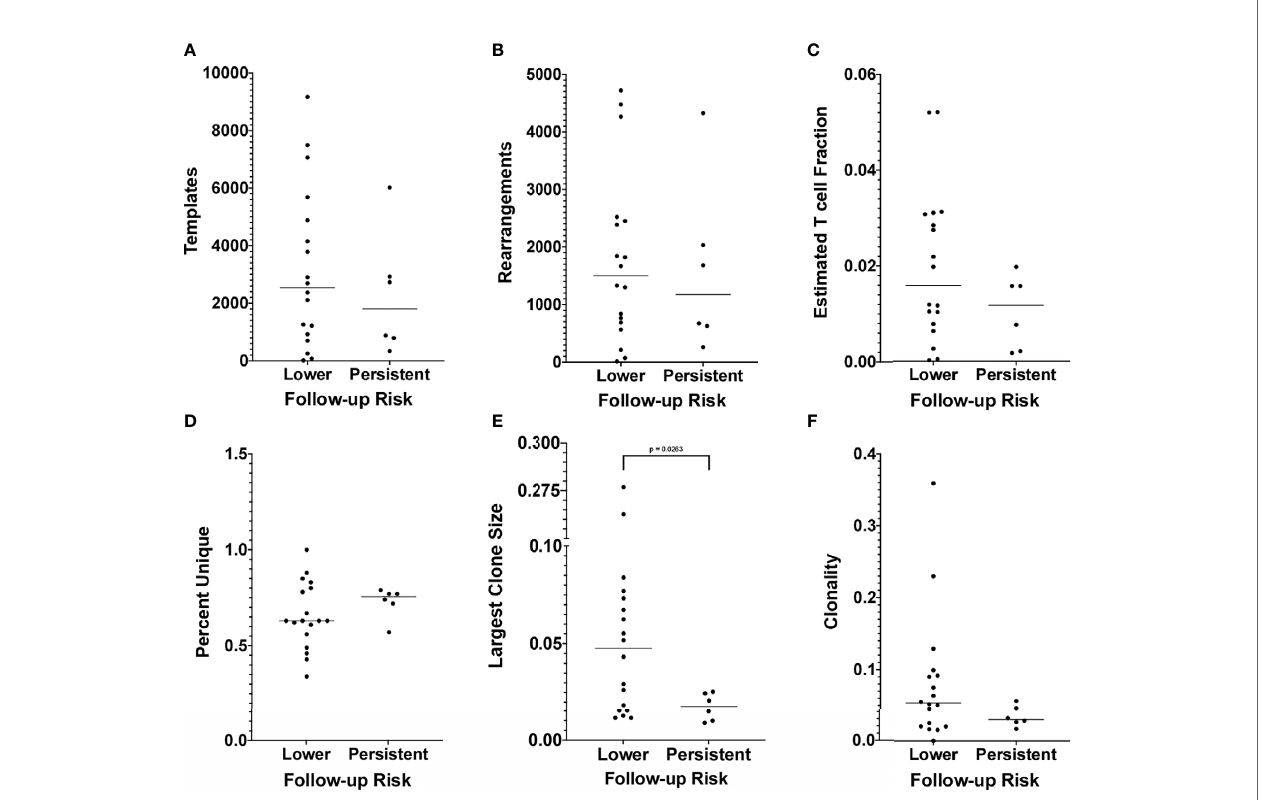
FIGURE 5 | (A) The number of productive templates obtained for each sample is shown on the y-axis. Other details as in Figure 4A . (B) The number of productive rearrangements obtained for each sample is shown on the y-axis. Other details as in Panel (A) . (C) The Fraction Productive of Cells Mass Estimate, referred to as the Estimated T cell Fraction, obtained for each sample is shown on the y-axis. Other details as in Panel (A) . (D) The percentage of productive templates that correspond to a unique nucleotide sequence obtained for each sample is shown on the y-axis. Other details as in Panel (A) . (E) The relative abundance of the largest clone obtained for each sample is shown on the y-axis. Other details as in Panel (A) . (F) The Productive Clonality (1 – normalized Shannon Entropy) obtained for each sample is shown on the y-axis. Other details as in Panel (A)